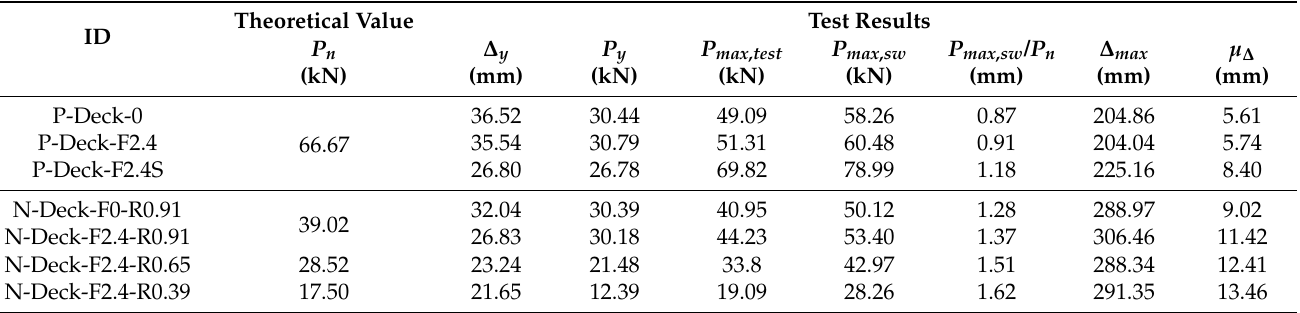
Table 7. Test results of ultimate flexural load.